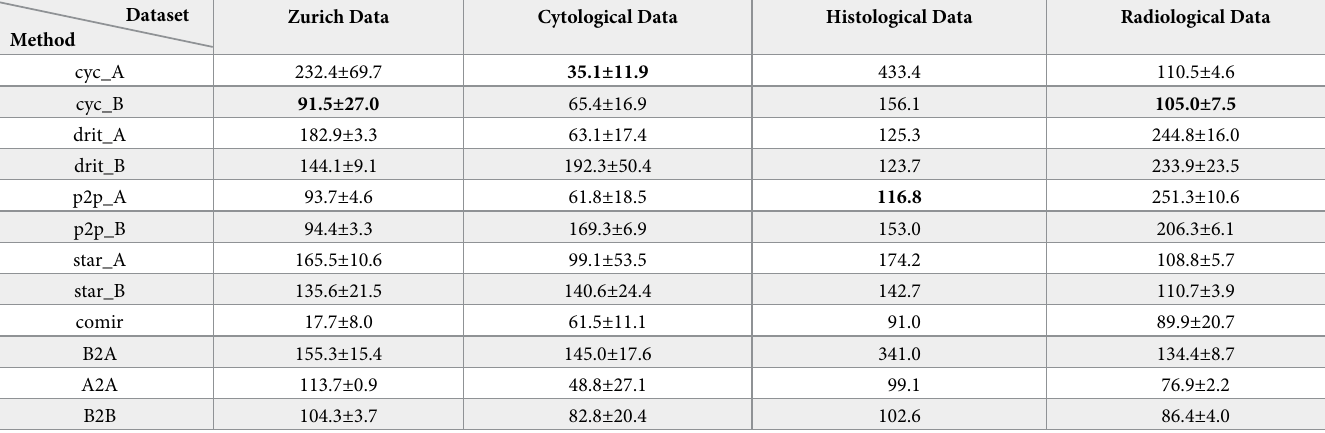
Table 1. Success of modality translation methods expressed in terms of Fre´chet Inception Distance (FID). Smaller is better. Standard deviations are taken over the 3 folds for Zurich, Cytological and Radiological data. cyc , drit , p2p , star , comir denote the methods CycleGAN, DRIT++, pix2pix, StarGANv2, and CoMIR, respec- tively. Suffix _A (resp. _B) denotes generated Modality A (resp. B). The best result achieved by an I2I translation method on each of the datasets is bolded. FID values between the initial considered multimodal image datasets ( B2A ), as well as between the training and testing splits within each modality ( A2A and B2B ) for each dataset, are included as references. FID values between the generated CoMIR representations are not directly comparable to those of the I2I translations, since the method gener- ates a different (artificial) modality. Comparison with the values for the original multimodal data (B2A) confirms considerable reduction of